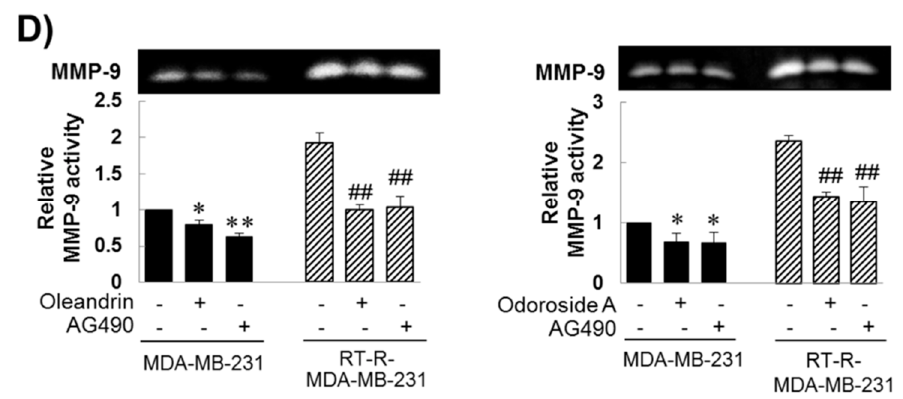
Figure 5. Inhibitory effects of oleandrin and odoroside A on Oct3/4, β -catenin, and MMP-9 through the downregulation of STAT-3 phosphorylation. ( A ) Phospho-STAT-3 and total STAT-3 protein levels were detected in the cell lysates of ECs, MDA-MB-231 cells and RT-MDA-MB-231 cells by Western blot analysis. ( B – E ) MDA-MB-231 and RT-R-MDA-MB-231 cells were treated with oleandrin (50 nM), odoroside A (100 nM) and AG490 (10 μ M; a phospho-STAT-3 inhibitor) ( B – D ) for 24 h. After treatment, phospho-STAT-3 ( B ), OCT3/4 and β -catenin ( C ) were determined by Western blot analysis, and MMP-9 activity was determined ( D ). The values are expressed as the means ± SEM from three independent determinations. * p < 0.05, ** p < 0.01 compared with the MDA-MB-231 control group; # p < 0.05, ## p < 0.01 compared with the RT-R-MDA control group.